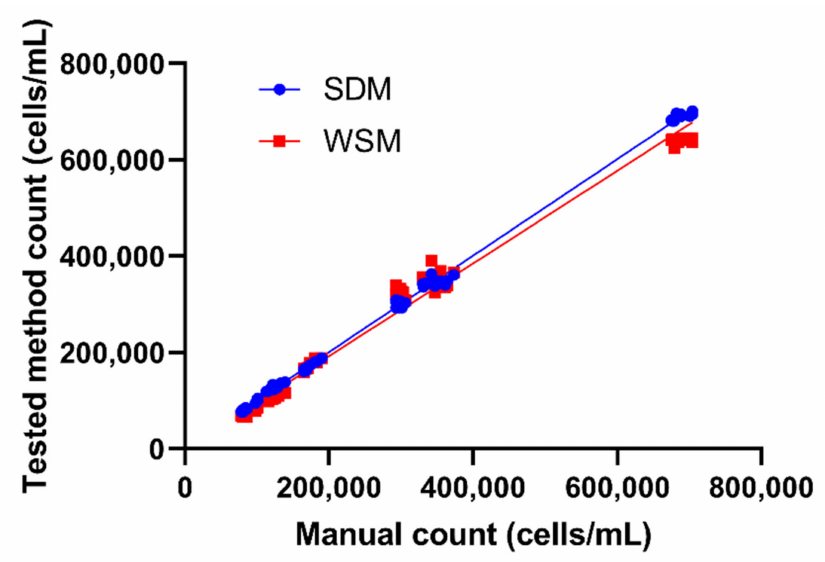
Figure 3. Deming regression of Tetrahymena cell count using either SDM or WSM on samples with a wide range of cell concentrations. For each method, cell counting data obtained from 80 different image captures were used for